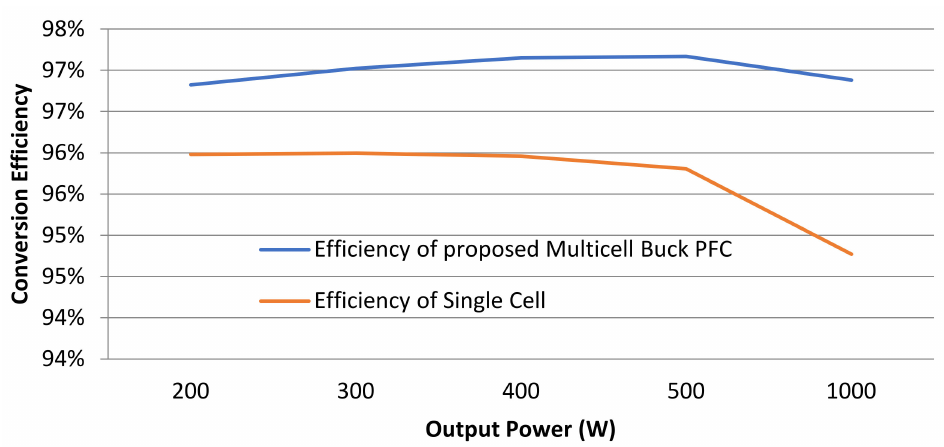
Figure 11. Efficiency comparison of single-cell and multicell